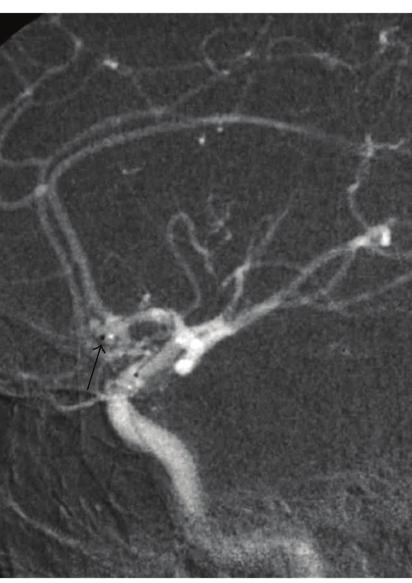
Figure 1: Left ICA road map during aneurysm coiling showing the tip of the microcatheter inside the Acom aneurysm. Note the elongated shape of the aneurysm (arrow).